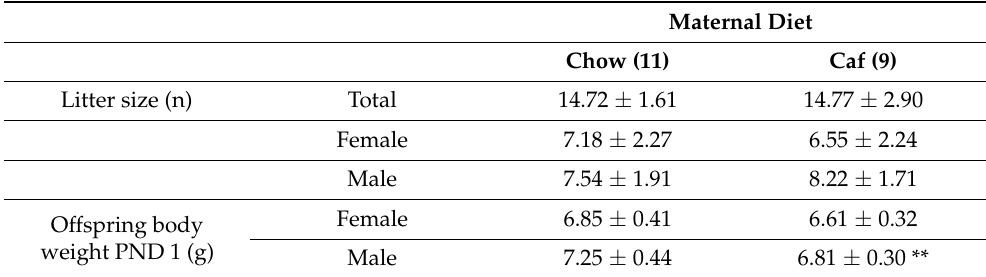
Table 1. Litter characteristics.